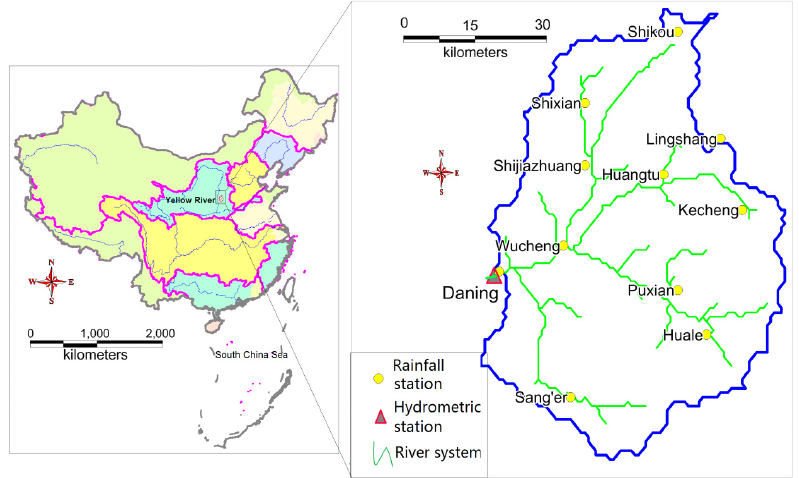
Figure 1. River system and locations of rainfall stations and the Daning hydrometric station in the Xinshui River catchment.